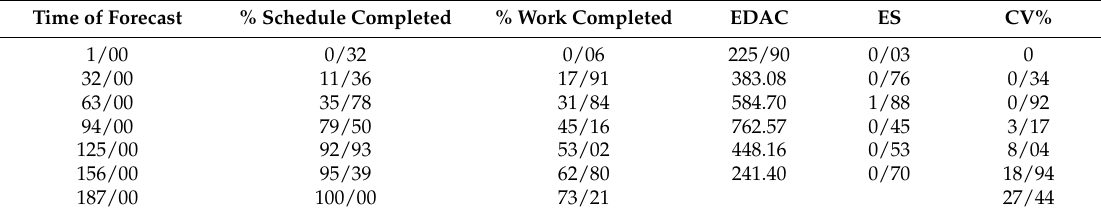
Table 2. Time series analysis with EVM formulae. EDAC, Estimate of Duration at Completion. Time of Forecast